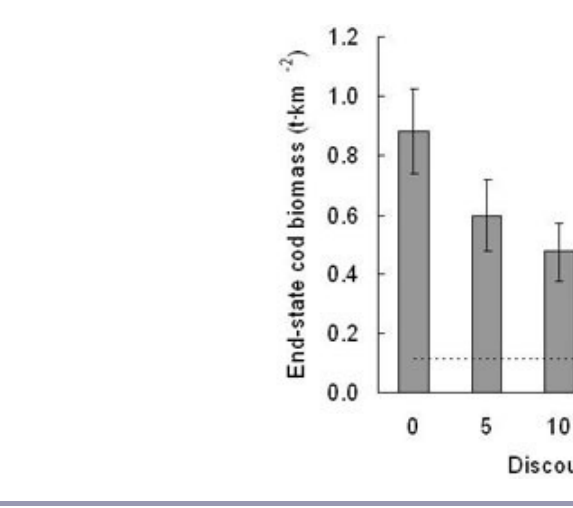
Fig. 1 . End-state cod biomass (year 2000) resulting from optimal catch strategies, maximizing the net present value at various discount rates. Modeling was performed using the Ecopath software suite (www. ecopath.org). A Monte Carlo procedure was used to vary basic Ecopath parameters (biomass, production, and consumption) for all species groups ( n = 20, CV = 0.2). Error bars indicate ±1 standard deviation around the mean. The broken line shows the real-world cod biomass in 2000, as estimated by virtual population analysis. This ecosystem model was adapted from Ainsworth and Sumaila